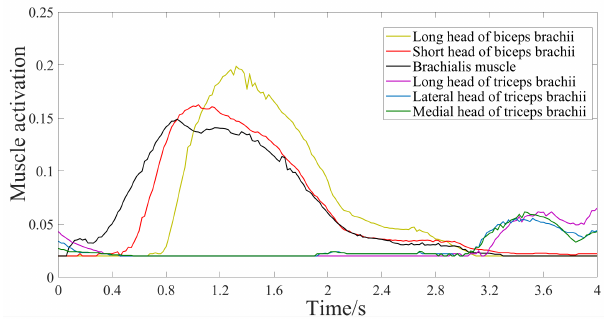
Figure 14. The related muscle activation obtained by